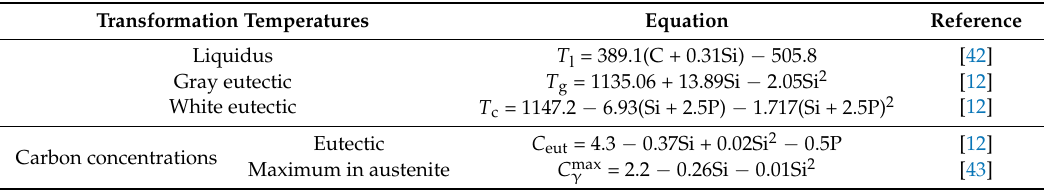
Table 2. Transformation temperatures and carbon